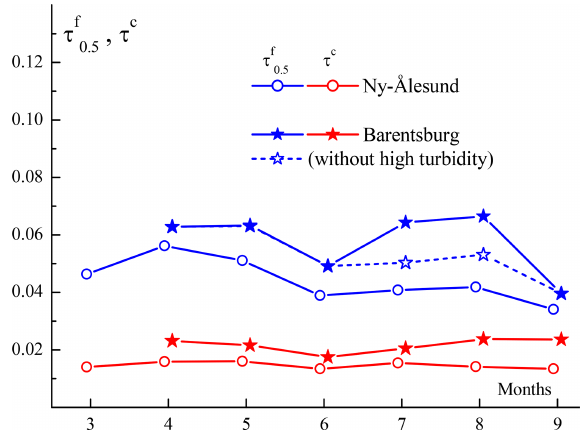
Figure 10. Seasonal variations in the fine and coarse AOD compo- nents in Ny-Ålesund and